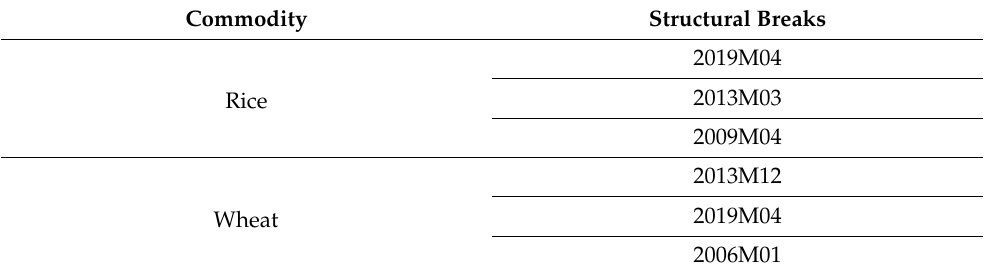
Table 4. Structural breaks for wheat and rice price series.